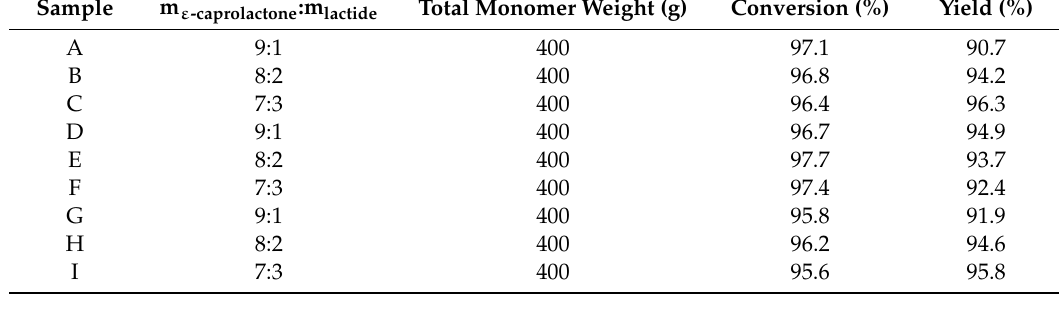
Table 2. Conversion and yield of copolymers.